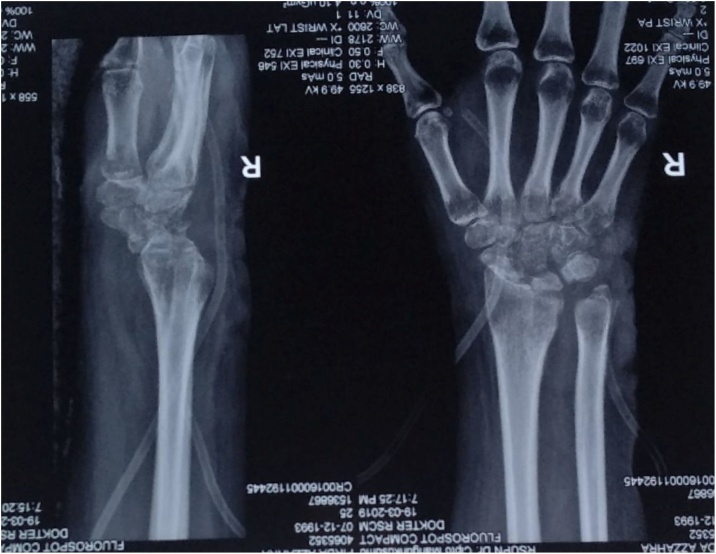
Postoperative X-Ray.